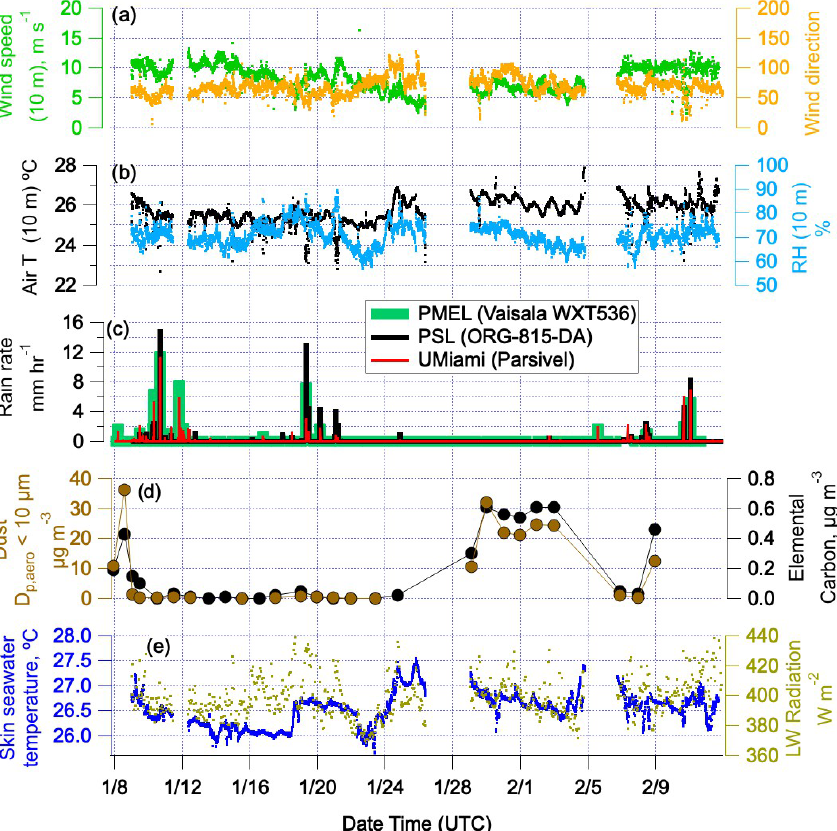
Figure 4. Time series of bow mast measurements of (a) wind speed and direction, (b) air temperature and relative humidity all adjusted to 10m height using the COARE 3.6 bulk model. Also shown are (c) rain rate measured with three different instruments, (d) dust and elemental carbon mass concentration for particles with aerodynamic diameters less than 10µm, and (e) skin seawater temperature from the sea snake and downwelling longwave